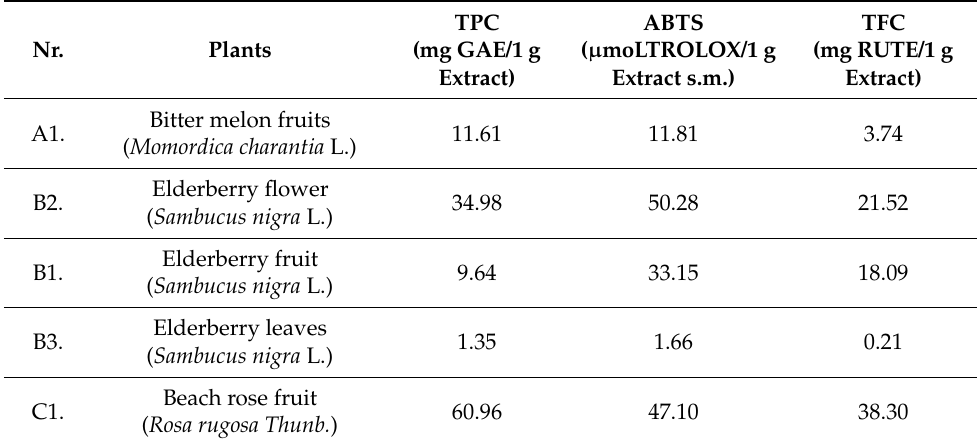
Table 1. The total phenolic content (TPC (mg GAE/1 g extract)), total flavonoid content (TFC (mg RUTE/1 g extract)), and ABTS + ((2,2 (cid:48) -azino-bis(3-ethylbenzothiazoline-6-sulfonic acid ( µ molTROLOX/1 g extract s.m.)) in the plants